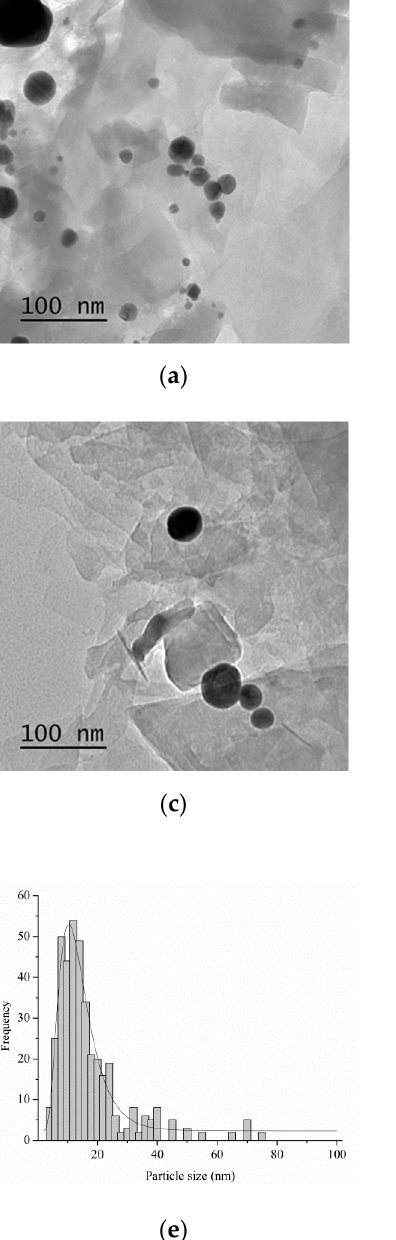
Figure 4. TEM overview of ( a,b ) fresh and ( c,d ) used (after five cycles) and particles distribution of ( e ) fresh and ( f ) used 1% Au IW /VPO catalysts.